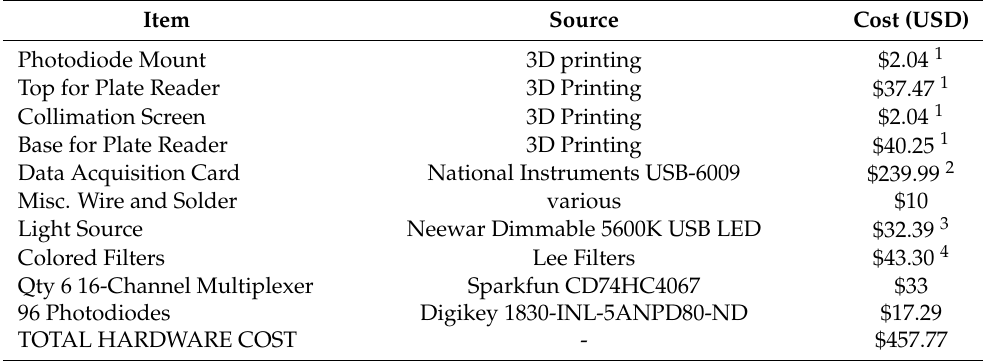
Table 1. Parts list and approximate cost in US Dollars for plate reader